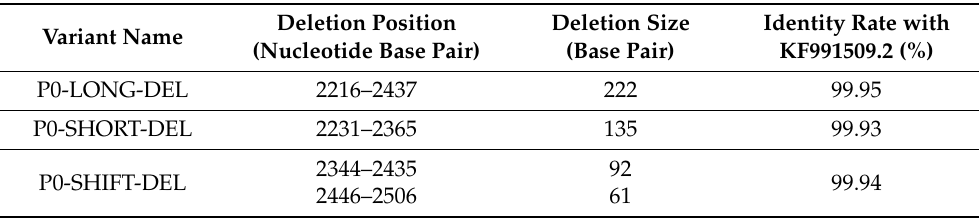
Table 3. Location and size of deletions in the full-genome sequences for the three different variants found in both Porcilis ® PRRS vaccine batches, and their percentage of identity compared to